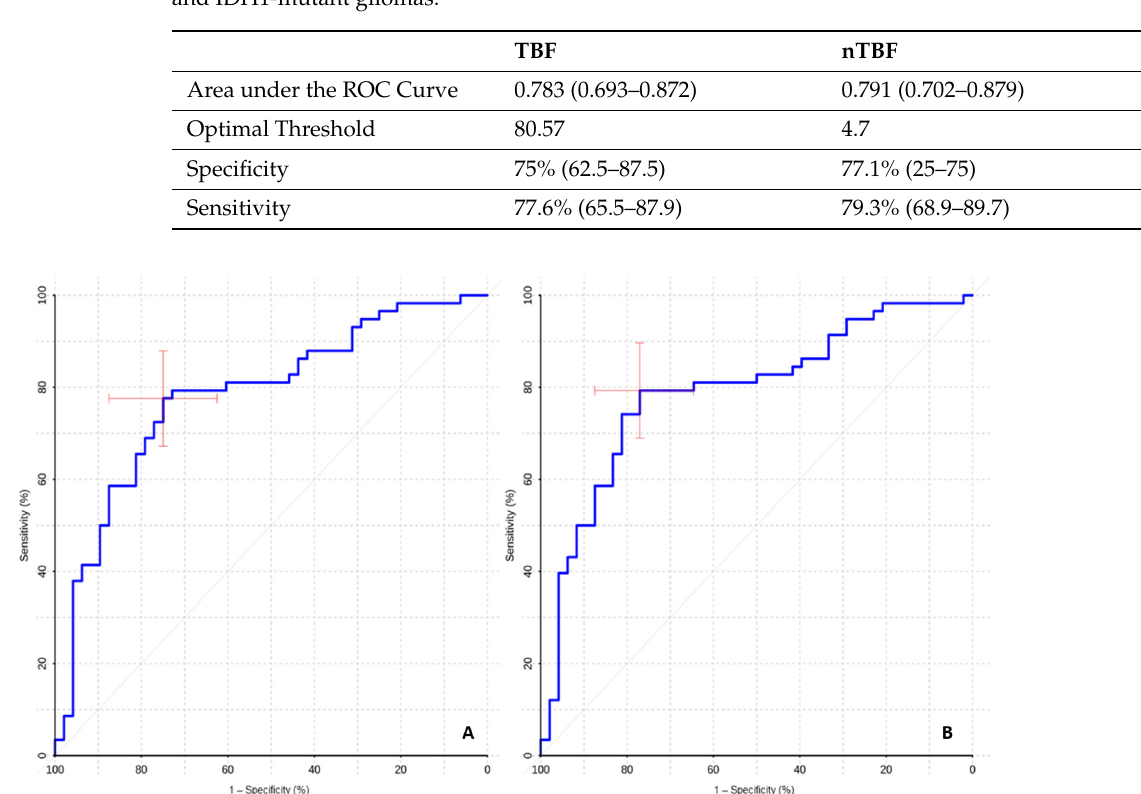
Figure 3. Boxplots of maximum ( A ) and maximum normalized ( B ) TBF in IDH1-wildtype and IDH1- mutant gliomas.